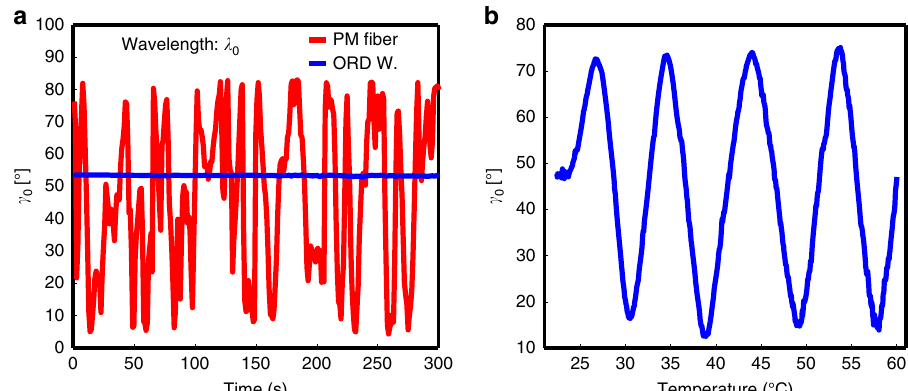
Fig. 3 Stability metrics. a Stability of the ORD wavemeter at a single wavelength ( λ 0 ) in a mechanically perturbed environment, where the vortex fi ber is shaken over a 5 min period. The change in OA angle, γ 0 , due to these perturbations is barely resolvable by our Fabry – Perot (< 0.4 pm). This is in contrast to the apparently unstable behavior of a birefringent PM- fi ber wavemeter. b Stability of the ORD wavemeter at a single wavelength ( λ 0 ) in a thermally perturbed environment, where the vortex fi ber is heated from 22 °C to 60 °C. The thermal expansion of the fi ber causes the OA angle to change with very systematic behavior. The mechanical and temperature stability tests both demonstrate how inherently resilient the ORD wavemeter is to perturbed environments, unlike the PM- fi ber which showed erratic